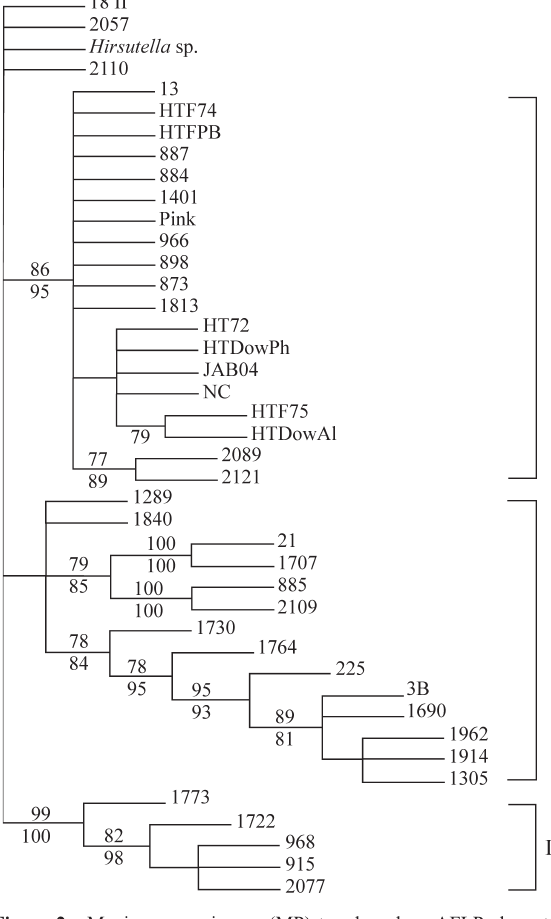
Figure 2 - Maximum parsimony (MP) tree based on AFLP characters. This tree also represents the topology obtained with the neighbor joining (NJ) analysis. Numbers next to the branches are bootstrap percentage val- ues, based on 1,000 replicates and obtained with MP (above) and NJ (be- low) analyses. The outgroup is Hirsutella isolate